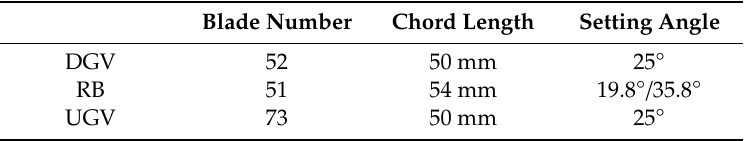
Table 1. Bidirectional turbine